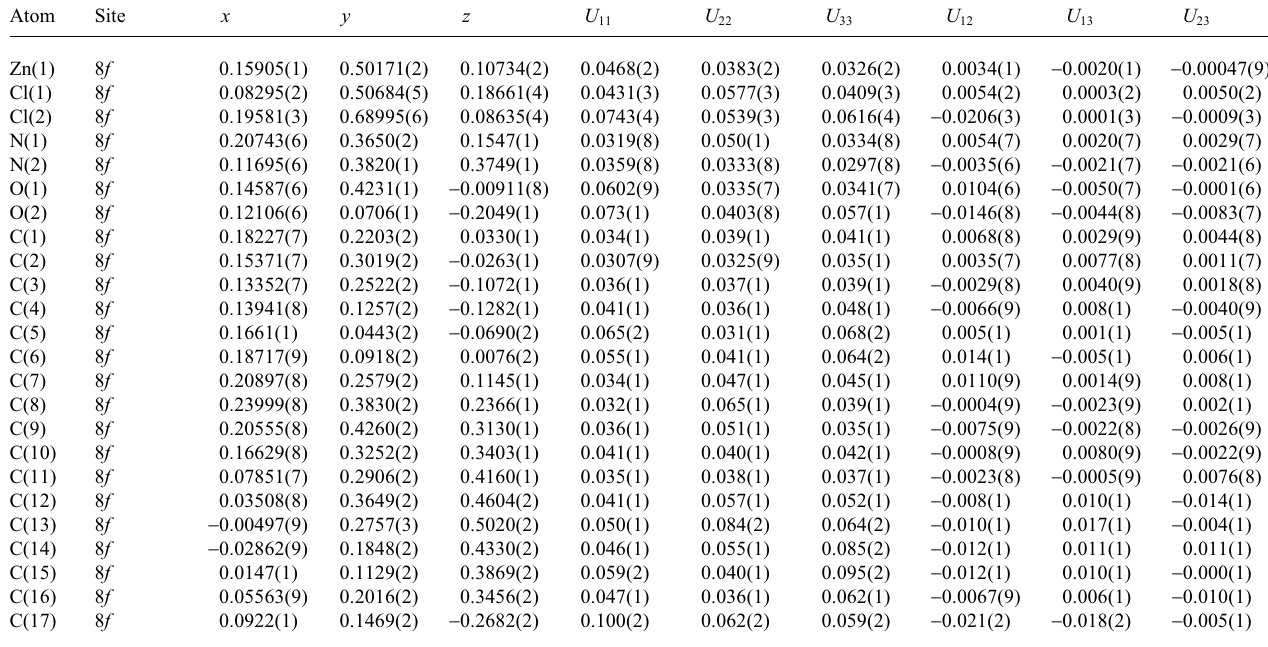
Table 3. Atomic coordinates and displacement parameters (in Å 2